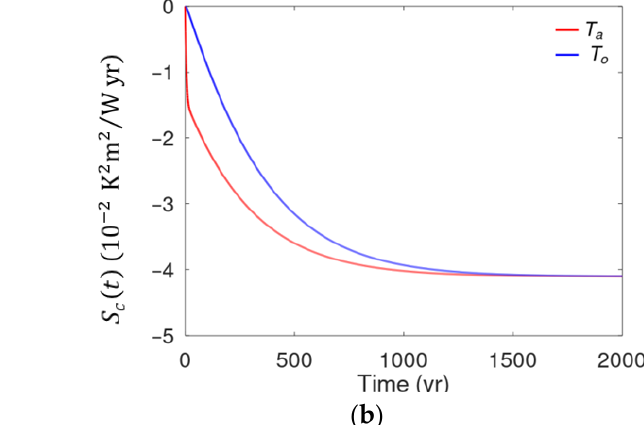
Figure 6. Sensitivities of global mean surface temperature (red line) and global mean deep ocean temperature (blue line) with respect to parameter 𝐶 (cid:3028) , calculated for linear forcing: ( a ) over time interval 0–200 years, ( b ) over time interval 0–2000 years.